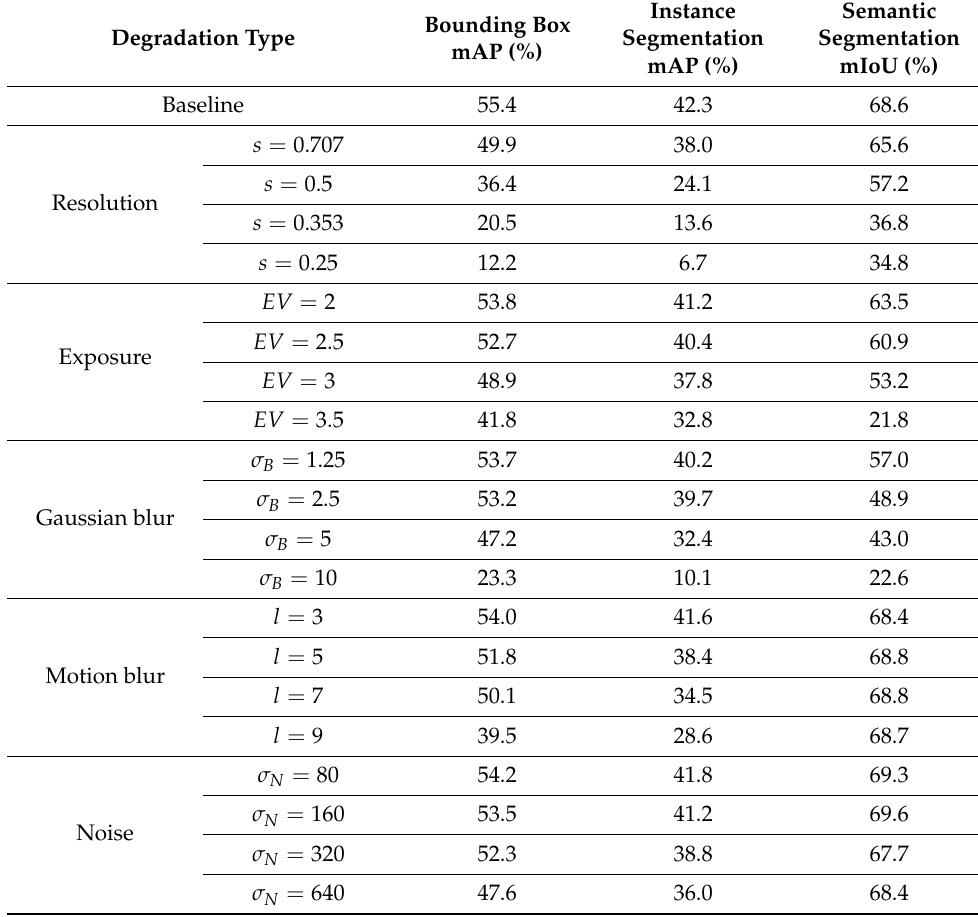
Table 5. Result of inference by CNN models trained on images with various levels of image degrada- tions and applied to the baseline testing